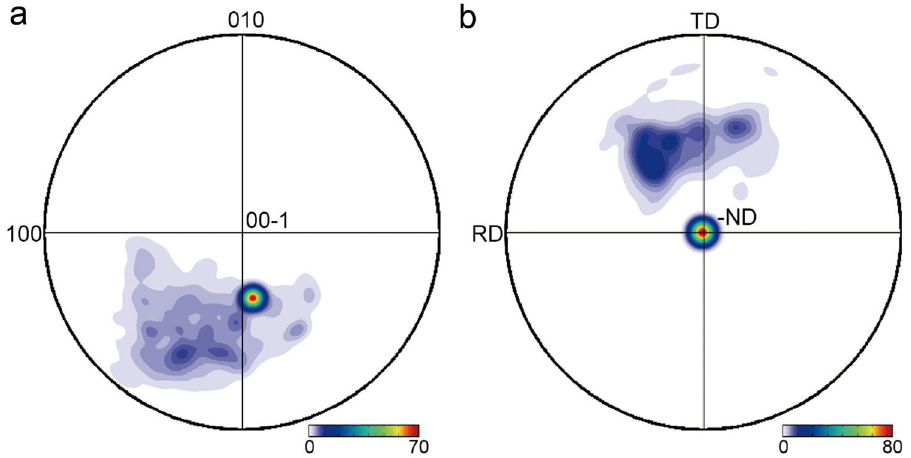
Figure 2. Distribution of boundary plane normals, determined at individual positions on boundary before annealing. The boundary plane normal is calculated in the crystal coordinate system of the recrystallized grain ( a ), and in the sample coordinate system ( b ). The strong peak in each figure corresponds to the facets observed in Fig. 1, while the clouds in the distribution are from the curved parts of the